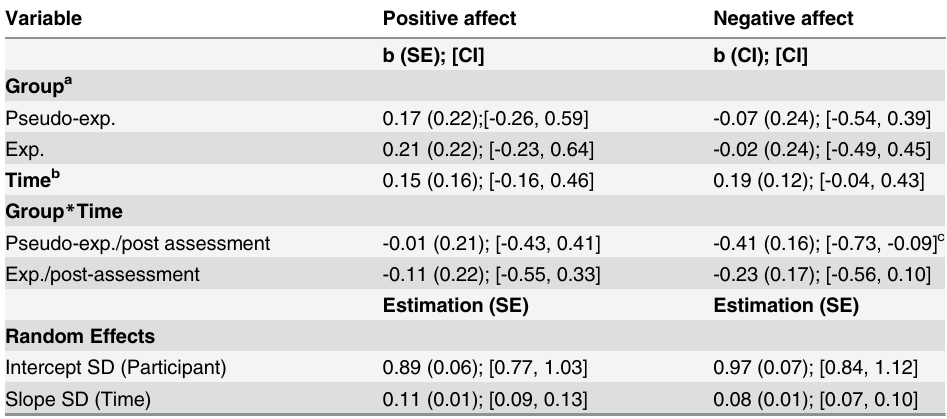
Table 2. Results of mixed effects models: Change in affect from pre to